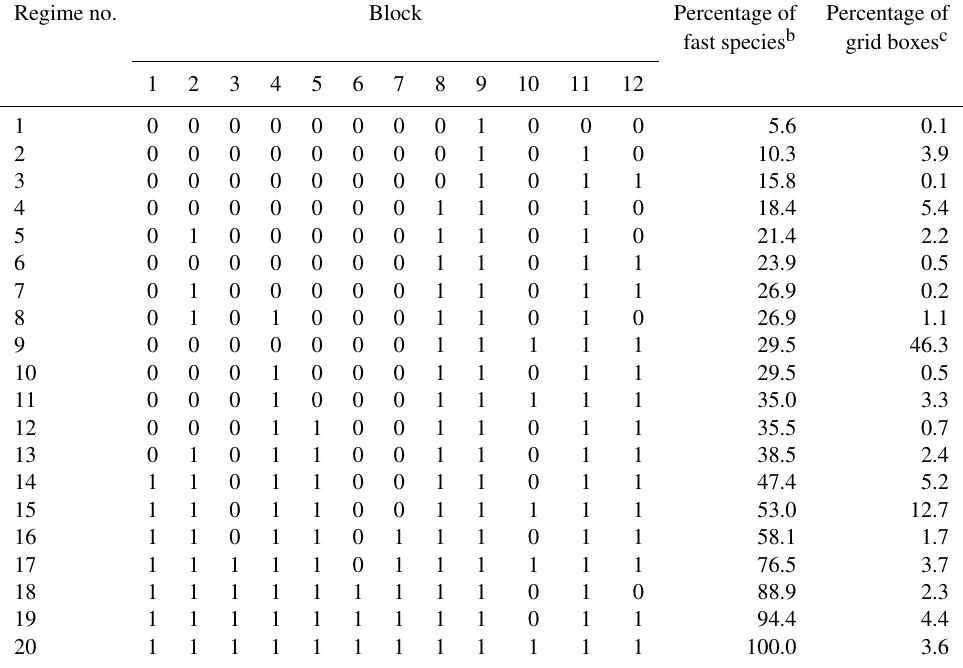
a The chemical regimes are defined by the ensemble of fast species that need to be treated as a coupled system with an implicit solution in the chemical operator. The species are assembled into blocks as listed in Table 1, and here we identify the blocks treated as fast in the chemical regime ( 1 ≡ fast, 0 ≡ slow). b Percentage of the 228 species in the GEOS-Chem chemical mechanism treated as fast in the chemical regime. c Global percentage of GEOS-Chem tropospheric and stratospheric grid boxes for which the chemical regime is selected. Values are for 1 August 2013 sampled every